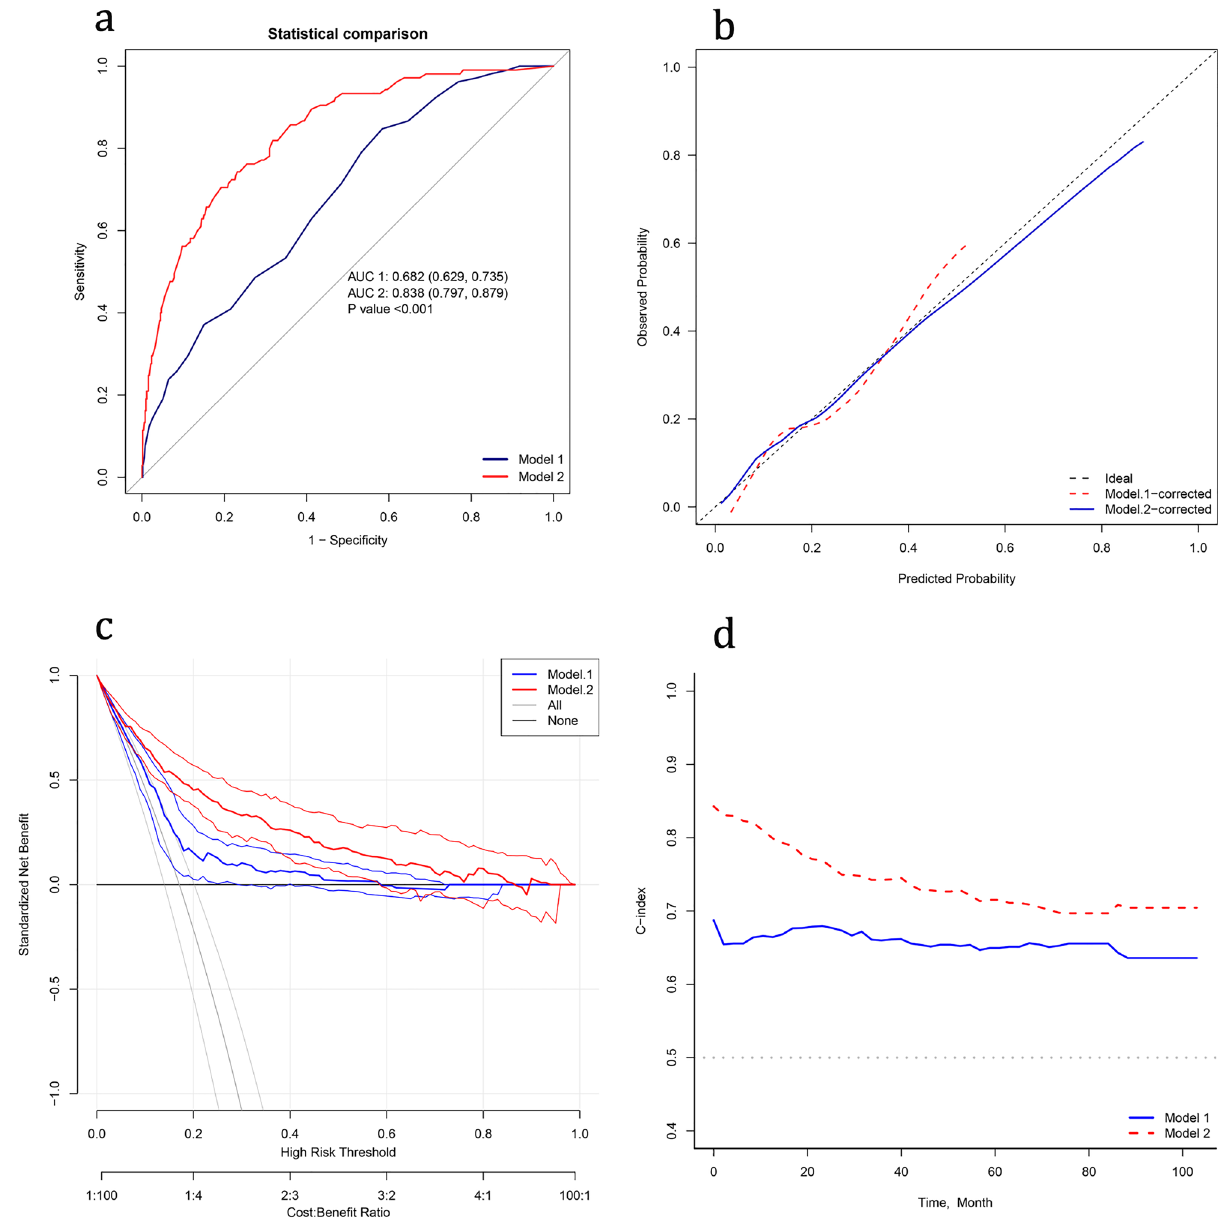
Figure 7. Comparison between our nomogram(model 2) and the MAGGIC score scale(model 1). ( a ) Comparison of ROC curves between model 1 and model 2. ( b ) Comparison of calibration curves between model 1 and model 2. ( c ) Comparison of decision curves between model 1 and model 2. ( d ) Comparison of C-index between model 1 and model